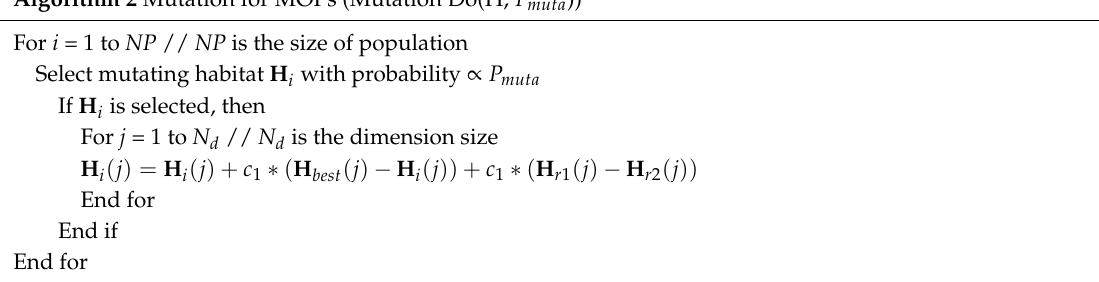
Algorithm 2 Mutation for MOPs (Mutation Do(H, P muta